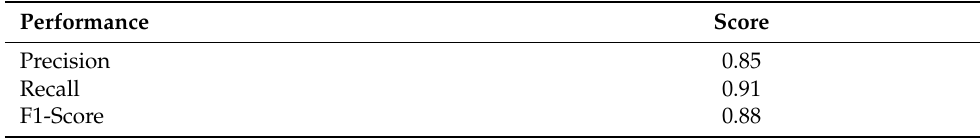
Table 4. Performance evaluation